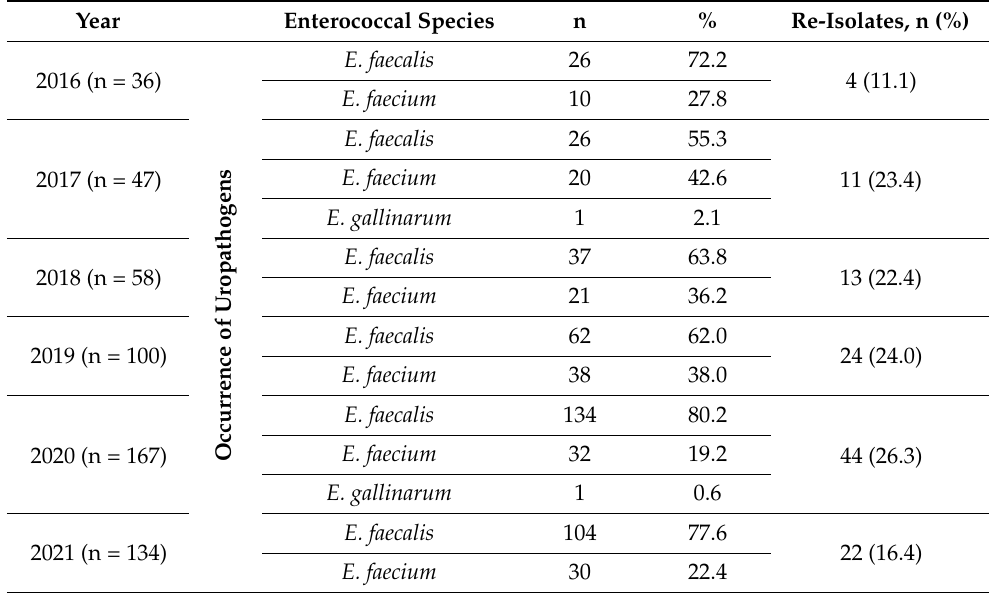
Table 1. The prevalence of enterococcal strains isolated from the urine of patients hospitalized in Nephrology and Urology Clinics between 2016–2021 and their species distribution.